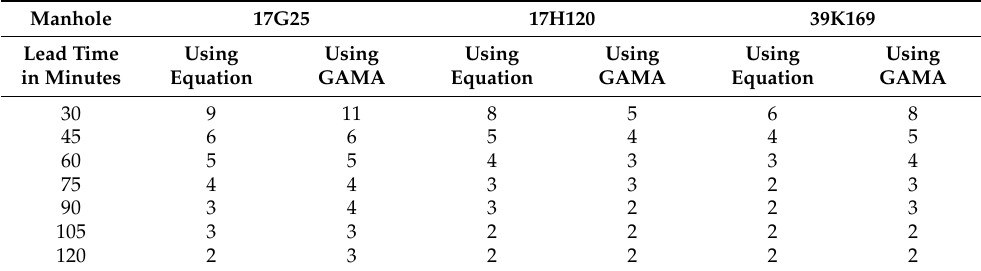
Table 5. Pairs of flood barriers installers needed to reduce damage costs for 100-year return period events. Manhole 17G25 17H120 39K169 Lead Time Using Using Using Using Using Using in Minutes Equation GAMA Equation GAMA Equation